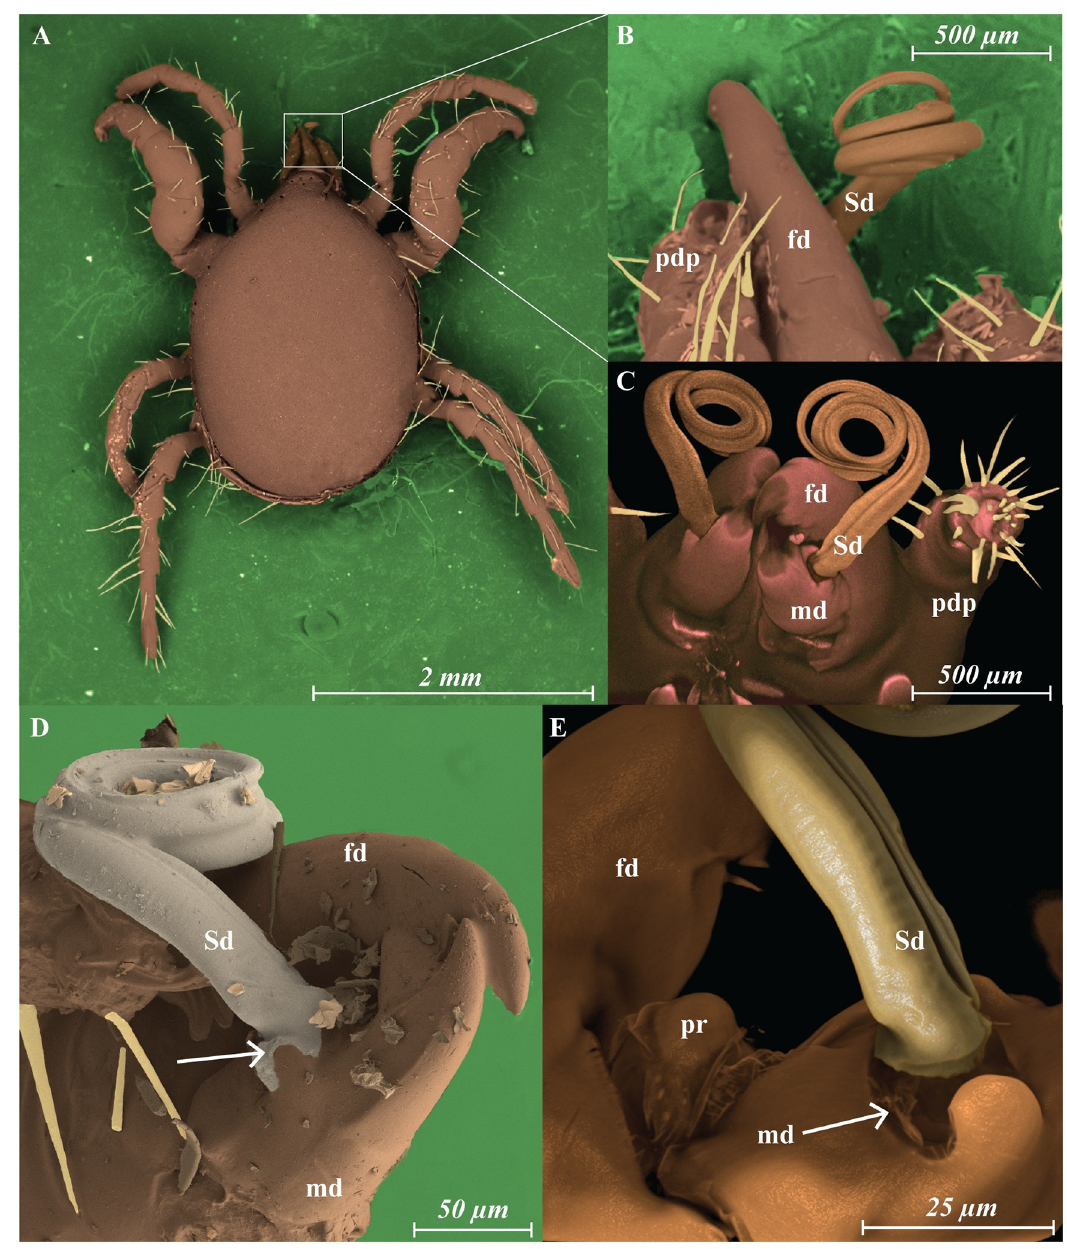
Fig 2. Megalolaelaps colossus male (A) dorsal view LT-SEM colorized image (B) lateral view of the spermatodactyl (C) frontal view of spermatodactyl CLSM colored image (D) colorized LT-SEM (E) colorized CLSM. Arrows: articulation between spermatodactyl and movable digit image. fd, fixed digit; md, movable digit; pr, putative reservoir; pdp, pedipalp; Sd, spermatodactyl.